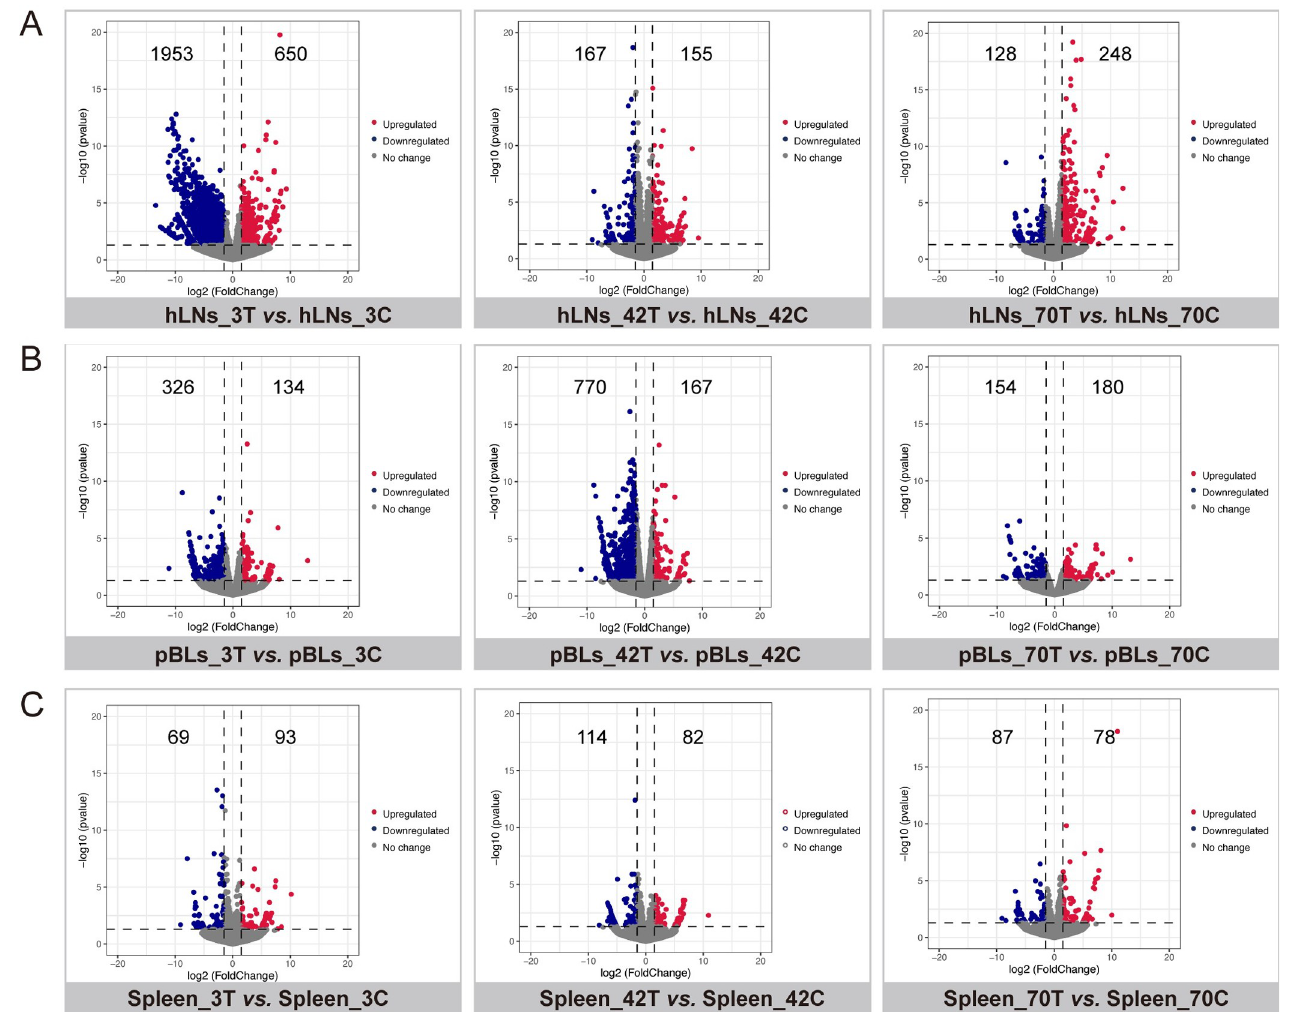
Fig 1. Volcano plots showing the differentially expressed transcripts (DETs) in different tissues of the buffaloes at 3-, 42- and 70-days post-infection (3, 42 and 70 dpi) ( P -value < 0.05 and |log2 fold-change| � 1.5). (A) DETs of hepatic lymph nodes (hLNs); (B) DETs of peripheral blood lymphocytes (pBLs); (C) DETs of spleen. Red dots represent the upregulated transcripts, blue dots represent the downregulated transcripts, and gray dots represent the unchanged transcripts in infected tissues.